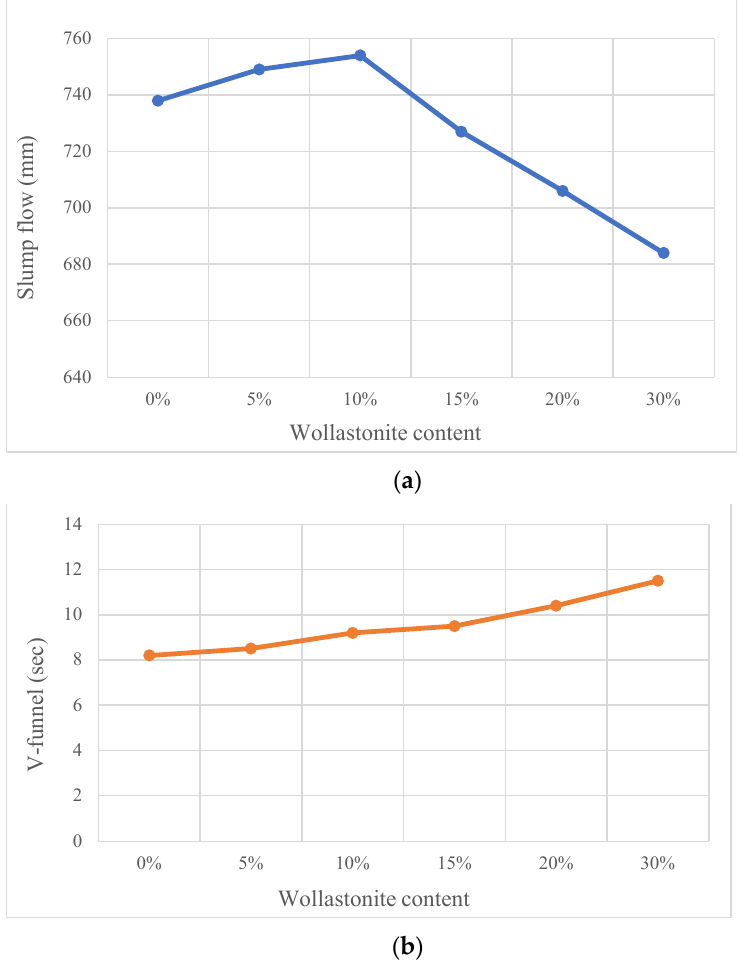
Figure 12. ( a ) Slump flow and ( b ) v-funnel of results of wollastonite based on Ref. [55].